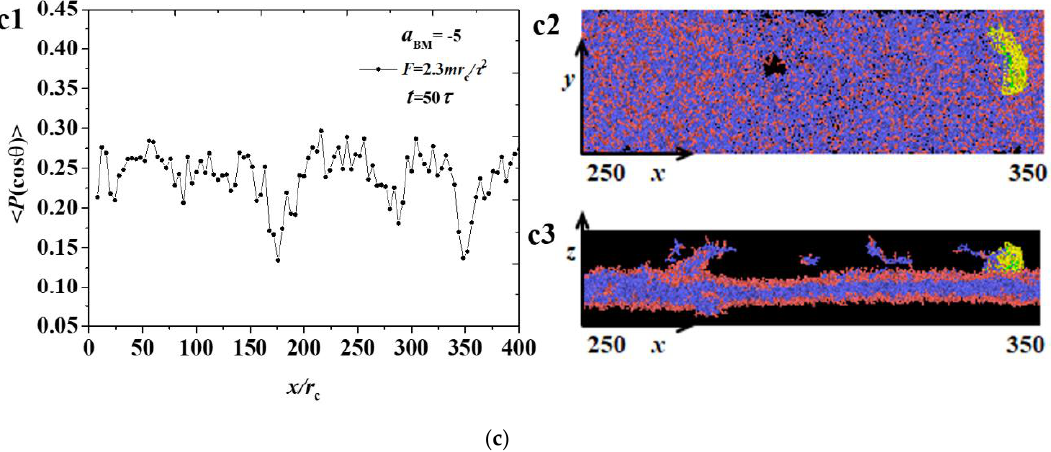
Figure 5. The distribution of order parameters P ( cos θ ) for the phospholipid membrane in the weak adsorption cases of a BM = − 5 and F = 2.3 mr c / τ 2 , where the membrane structures are also displayed. Three time stages, ( a ) t = 0 τ , ( b ) t = 40 τ , and ( c ) t = 50 τ , are demonstrated.